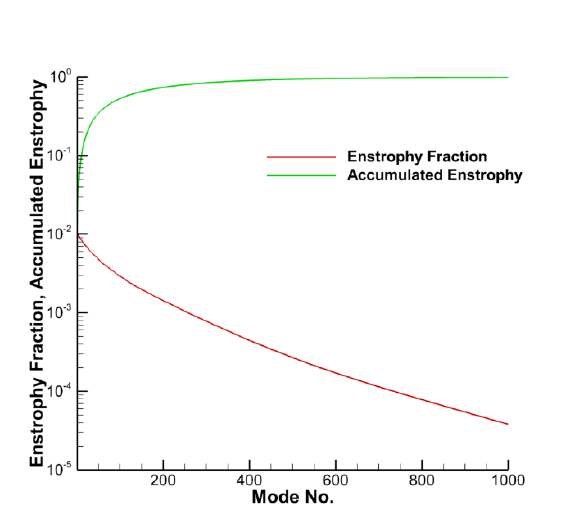
Fig. 15. Enstrophy distribution across vorticity POD modes. Examples of the vorticity POD modes topologies are to be shown in Figs. 16-20 representing the modes Nos. 1, 2, 3, 20 and 100 respectively. Distribution of the vorticity component in z direction, red – positive, blue – negative (clockwise).